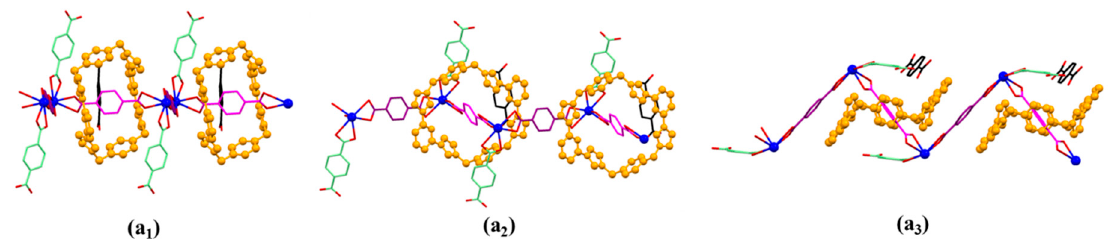
Figure 5. Top ( a 1 ), front ( a 2 ), and side ( a 3 ) views of the 1D polyrotaxane structure unit of MORF-Pb-1 found in the single crystal structure of [ 1 4+ • ( 2 ) 4 • (2H + • 2 ) • Pb 2 • 2DMF • 12H 2 O] (MORF-Pb-1). It is found that the distance between two neighbouring Pb 2+ on different 1D polyro- taxane is 3.656 Å (shown in Figure 6a), which is larger than the sum of two Pb 2+ ionic